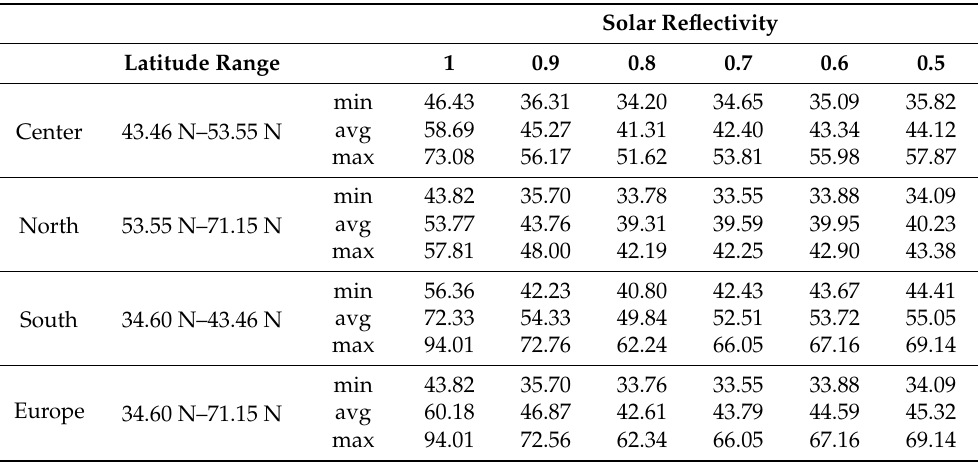
Figure 5. Power potential for each observation in Batman during the month of February and for each value of solar reflectivity. Blue points correspond to radiative cooling observations and red points correspond to solar heating observations. Red observations were discarded in calculations. Table 4. Minimum, average and maximum values for each solar reflectivity. Potential maps of RC power (W/m 2